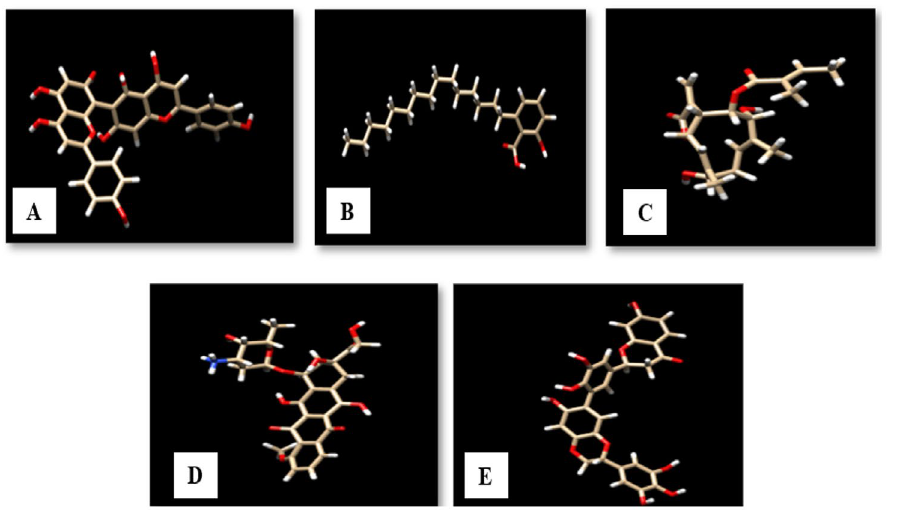
Fig. 3. 3D structure of A: Agasthisflavone, B: Anacardic acid, C: Zoapatanolide A, D: Doxorubicin and E: table 2. Residues of the target molecule p38α MAP kinase interacting with the three ligands: Zoapatanolide A, Agasthisflavone and Anacardic acid, a standard drug Doxorubicin and Amarogopinois546. Name of the H-bond interaction Amino acid residues of targe Biomarker